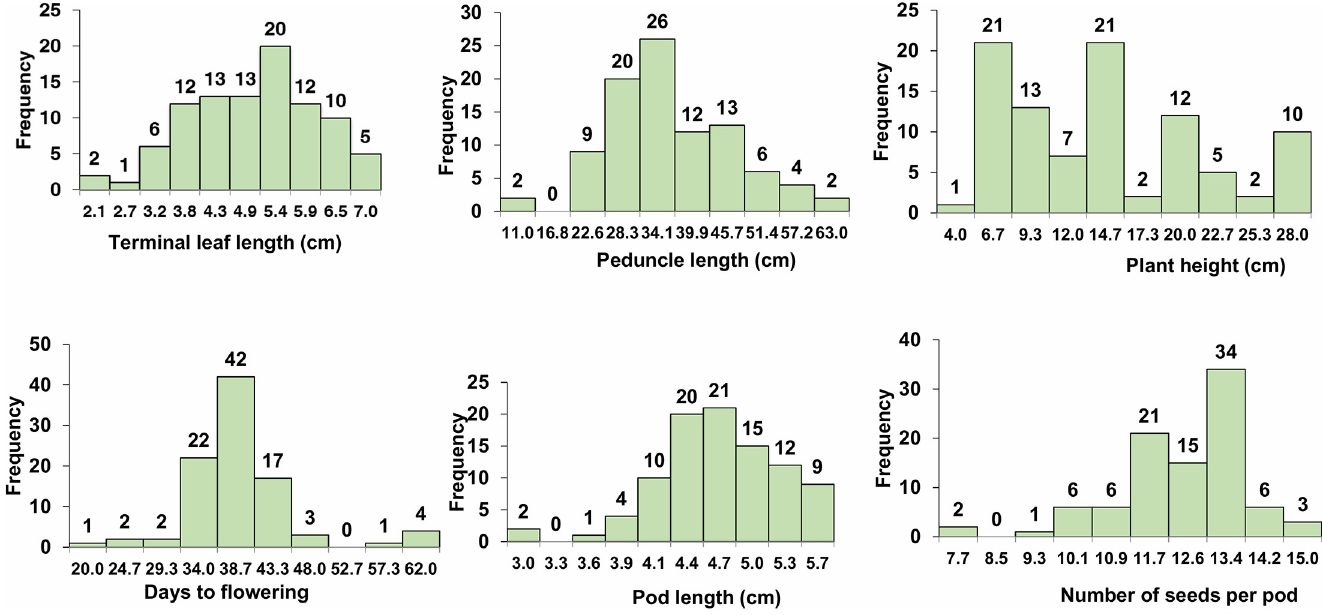
Fig 1. Frequency distribution of V . stipulacea accessions for quantitative traits.